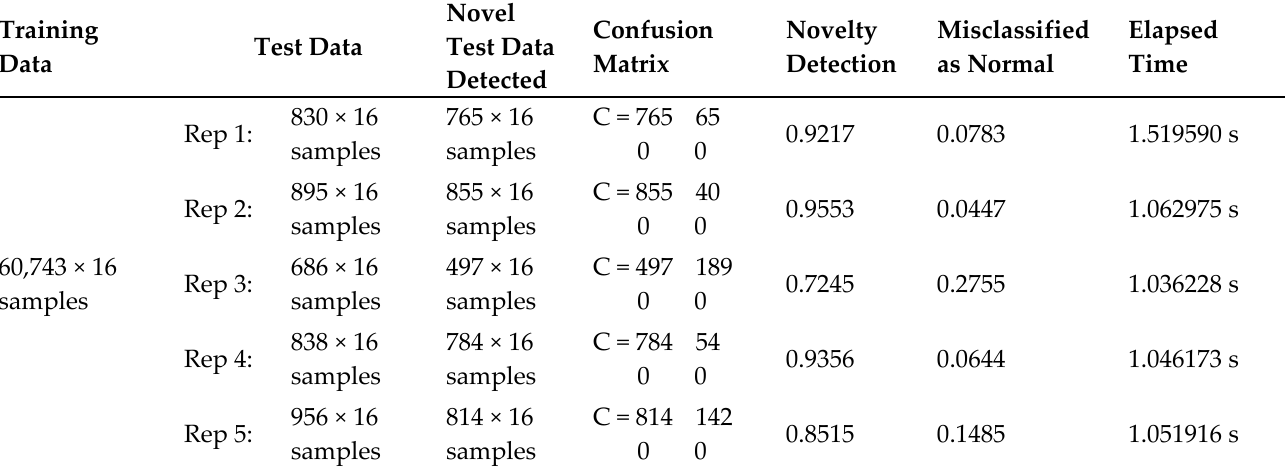
Table 3. iForest algorithm.